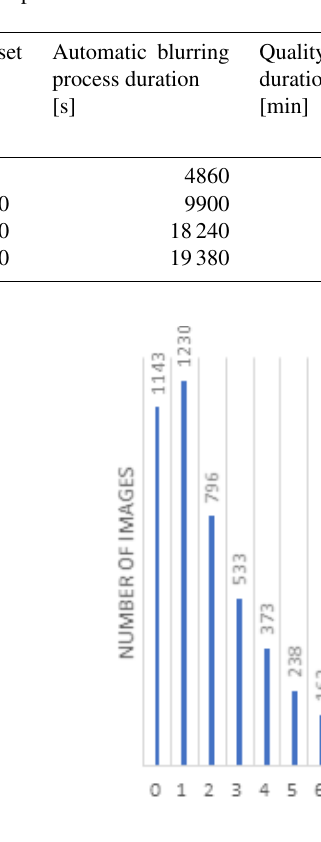
Table 2. Experimental results.